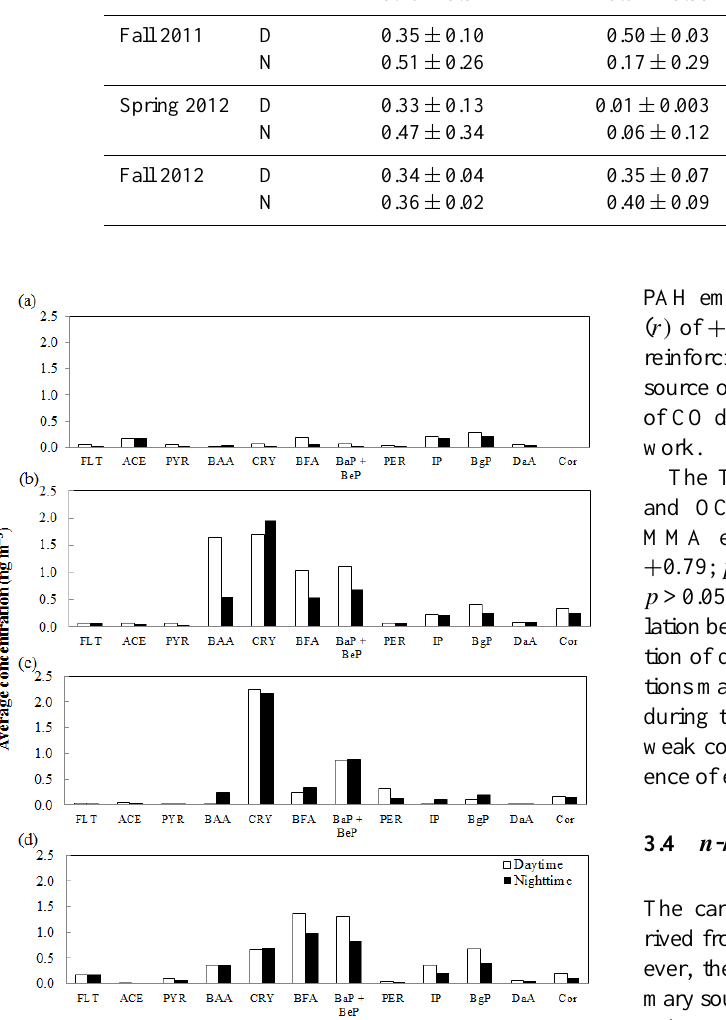
Figure 4. Mass concentration distribution of PAHs in the Monter- rey metropolitan area (MMA) for (a) spring 2011, (b) fall 2011, (c) spring 2012, and (d) fall 2012. Coronene was included in all monitoring campaigns except in spring